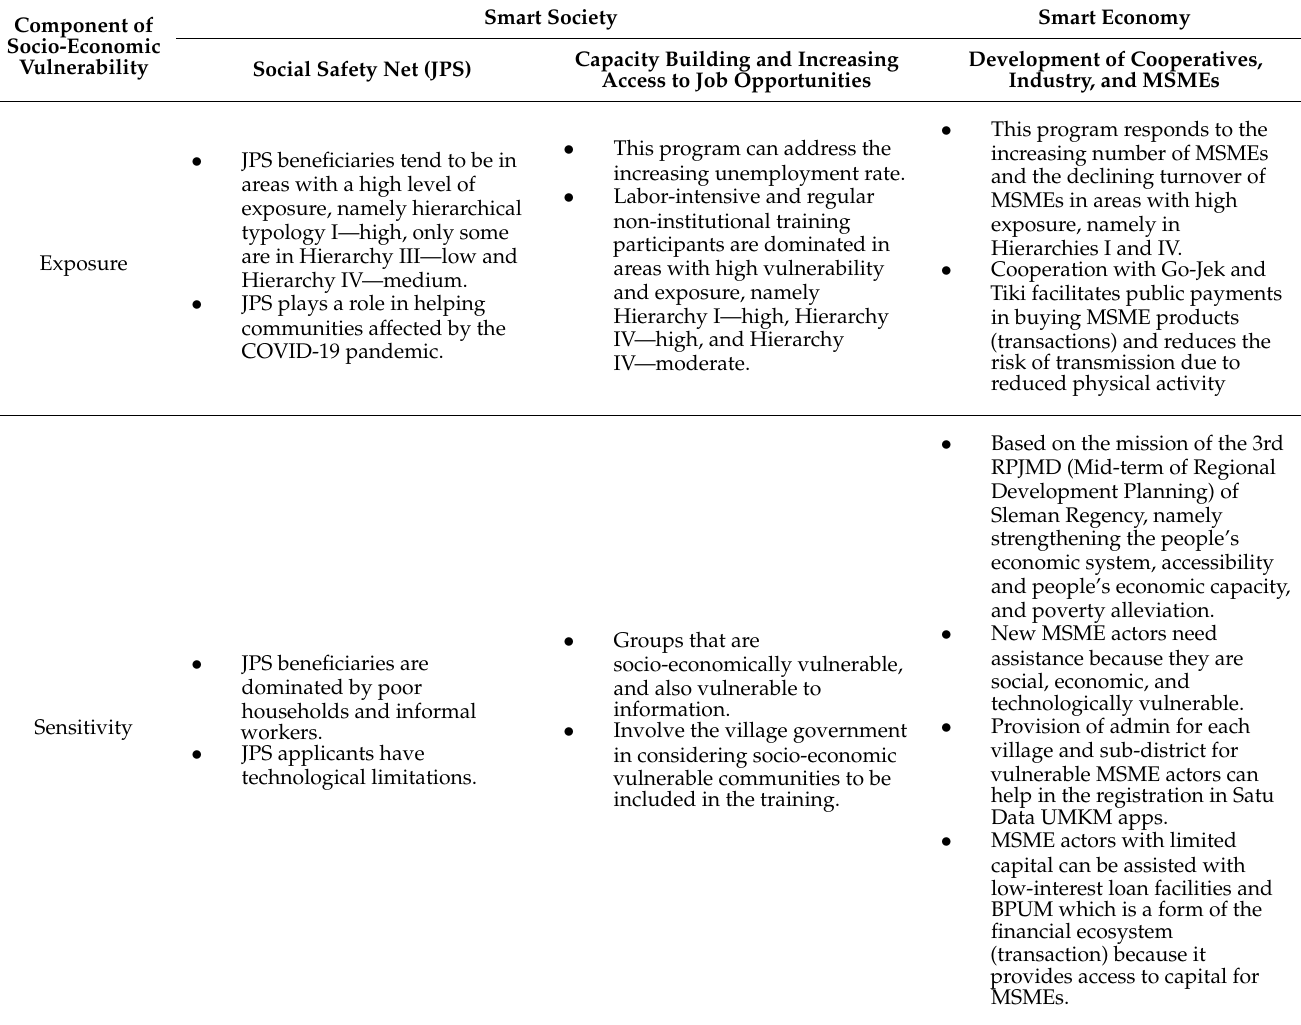
Table 2. The relationship between socio-economic vulnerability components and the dimensions of smart society and smart